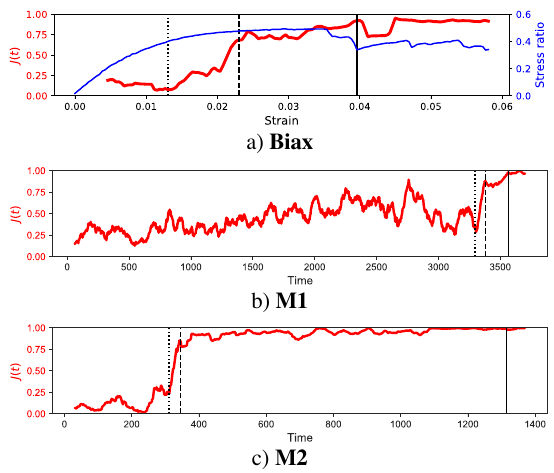
Fig. 2. Time evolution of the Jaccard index 𝐽 . For Biax , the stress ratio is included and the axial strain states correspond to the analyzed time states. The initial transition state, 𝑡 𝑖 (dotted line), is the state from which the clustering persistence rapidly increases. The earliest state when the clustering pattern stabilizes, 𝑡 ∗ (dashed line), may be used as an indicator of imminent failure. Time of failure is 𝑡 # (solid line).